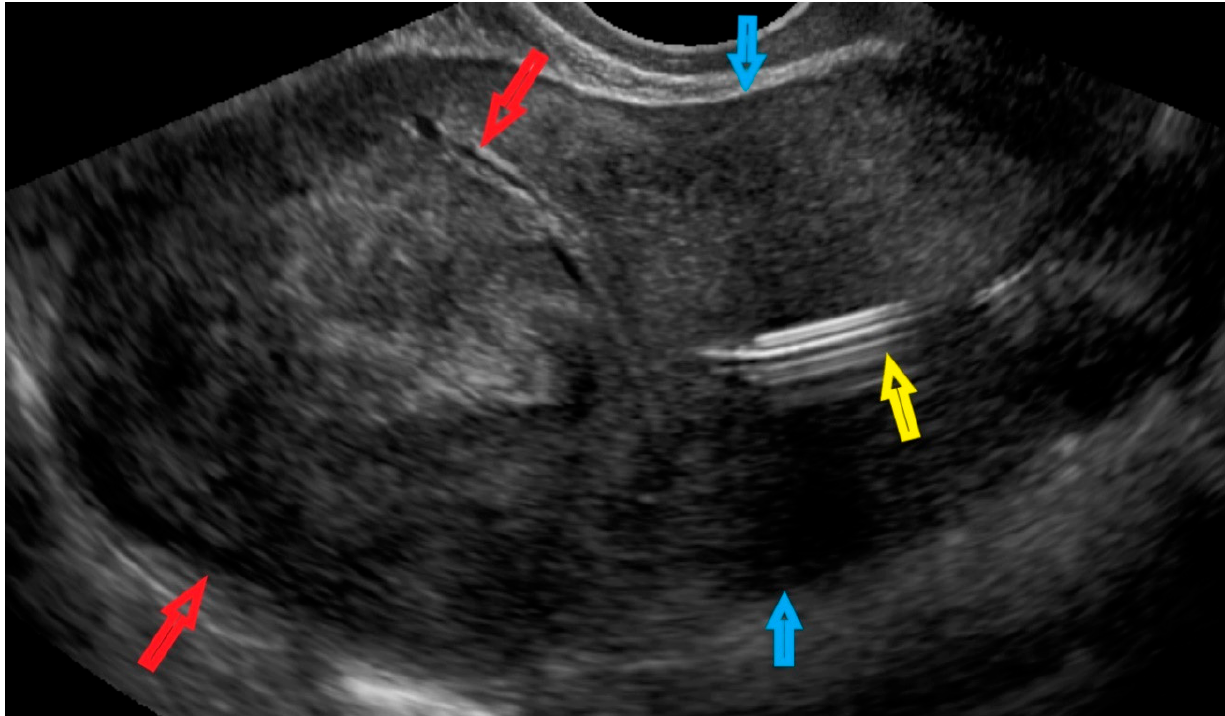
Figure 2. Transvaginal ultrasonogram of the uterus in a patient. Red arrows indicate a lesion in the myometrium in the uterine doom; blue arrows indicate the uterine corpus; and the yellow arrow indicates an intrauterine device.